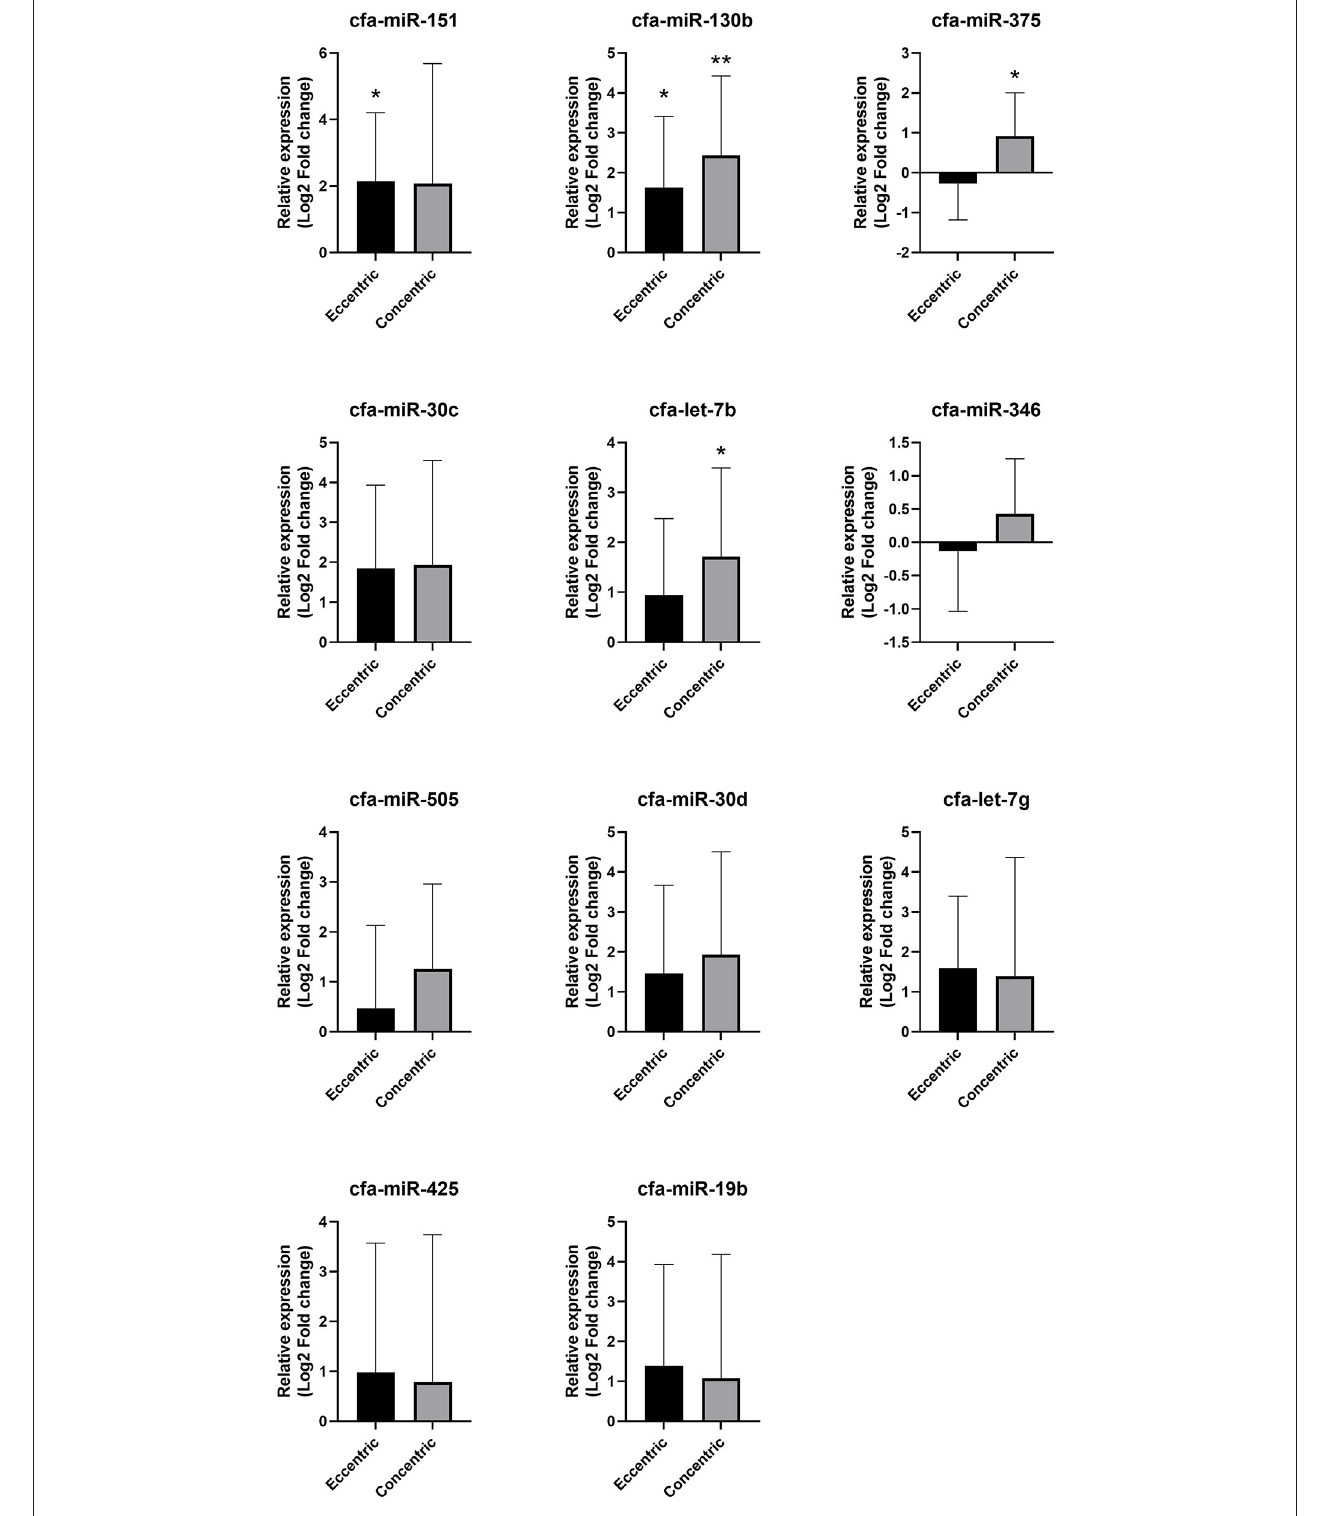
FIGURE 7 | Relative expressions of circulating miRNAs according to cardiac hypertrophy type. Data were presented as log2 transformed fold change relative to the healthy group (mean and standard deviation). * p < 0.05, ** p < 0.01 in one-way ANOVA among healthy, eccentric hypertrophy, and concentric hypertrophy groups, p -value adjusted by Dunnett’s multiple comparison